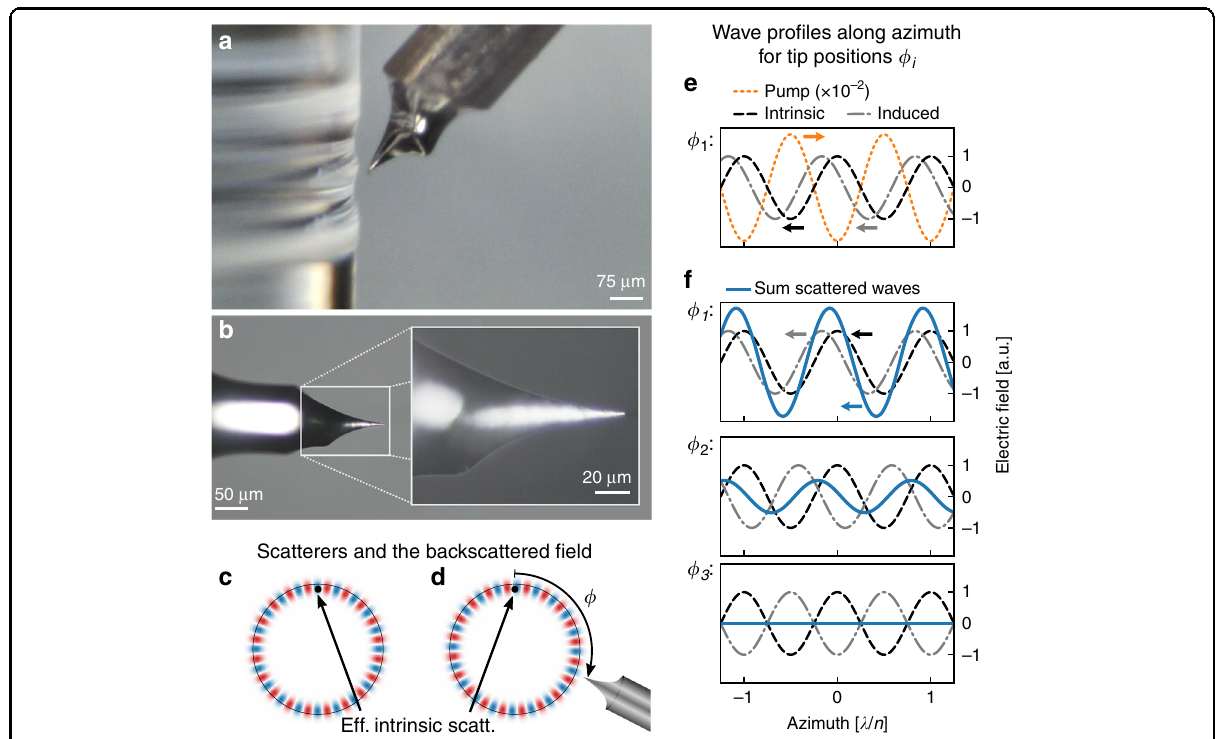
Fig. 1 Principle of backscattering control. a – b Micrographs of the microresonator and tungsten tip. c Illustration of the real part of the backscattered fi eld (cavity size and wavelength not to scale); the scatterer is represented by one effective scatterer here (black dot). d Introducing a second scatterer at an azimuthal angular distance ϕ from the effective scatterer, the backscattered fi eld changes depending on ϕ . e Illustration of wave pro fi les along the azimuth showing the counter-clockwise-propagating backscattered waves due to the clockwise-propagating pump fi eld. The backscattered fi eld amplitudes are small compared to the pump, as only a small fraction of the light is backscattered. The tip is critically coupled (equal amplitudes for intrinsic and induced backscattered waves). f Backscattered waves and their sum under critical coupling (equal amplitudes) for different azimuthal positions ϕ i of the tip, corresponding to phase offsets between the effective intrinsic scatterer and the induced scatterer (2 m + q ) π for integer m and q = 1 / 3, 5 / 6 and 1, showing both constructive and destructive